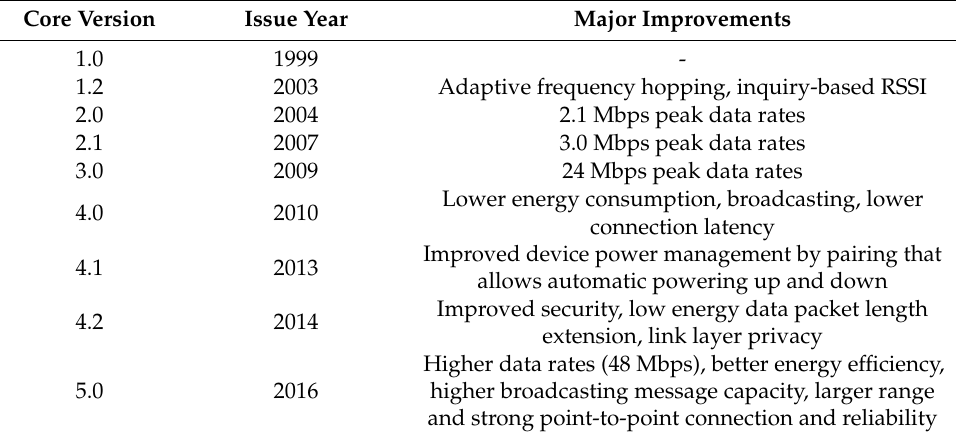
Table 2. Improvements in Bluetooth versions